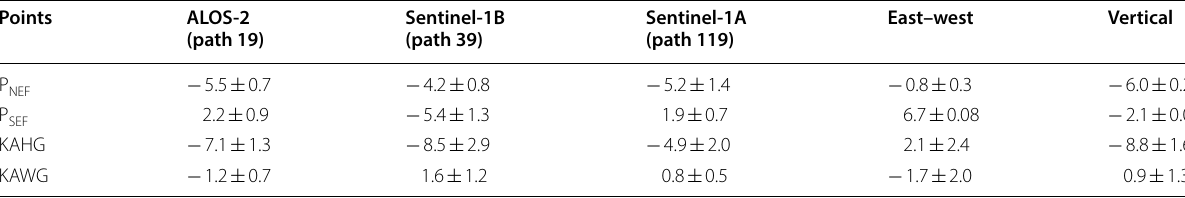
P NEF and P SEF are located at the center of NEF and SEF (Fig. 7a), respectively; KAHG and KAWG are GNSS stations located at the edge of the Kamayama summit crater (Fig. 1). All the values are in mm/year